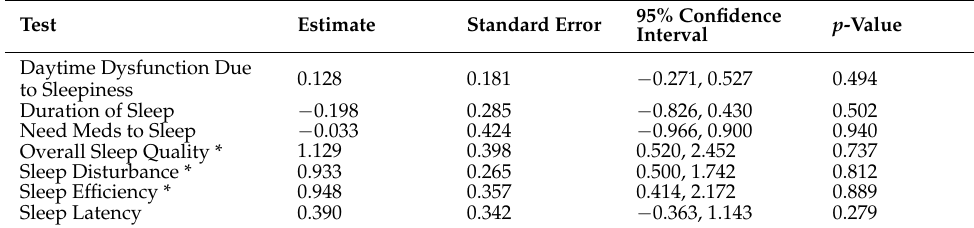
Table 6. PSQI scores—change from baseline estimates.